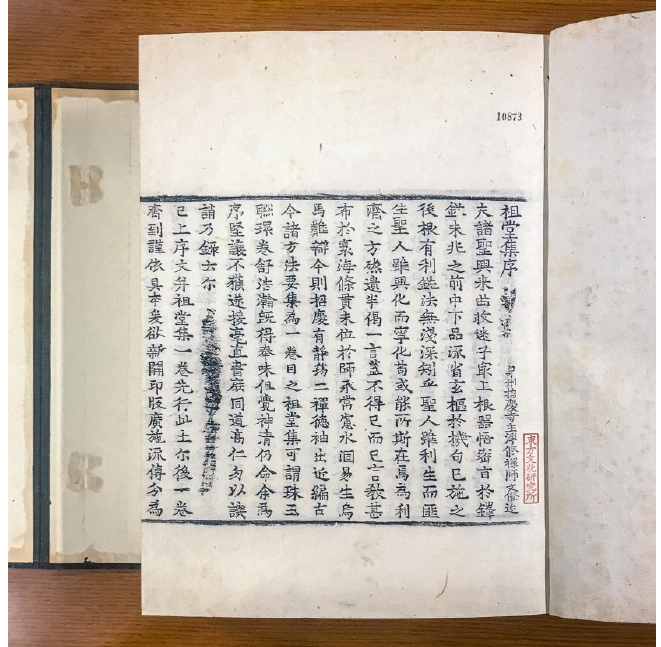
Figure 4. First half of the first zh ā ng of the ZTJ containing the preface of Jìngxi ū and the beginning of the Goryeo preface. The print of the zh ā ng is folded into two (photograph by Christian Wittern). Because the quality of the prints may vary and they are subject to small